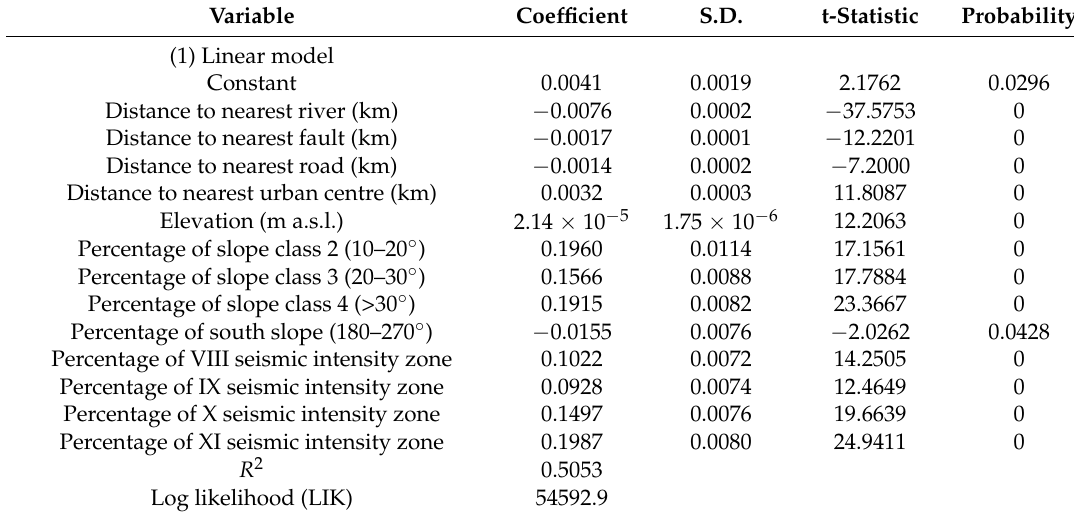
Table 7. The model parameters of three different models for all damaged vegetation at aggregation level 1 ×